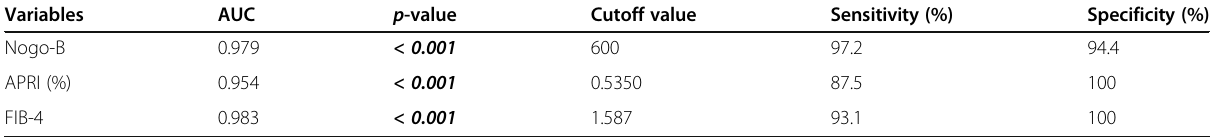
Table 4 Validity of serum Nogo-B, APRI, and FIB-4 in detecting hepatic patients Variables